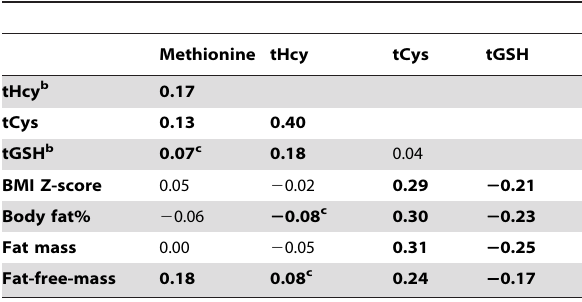
Table 2. Correlations among the sulfur amino acids and body composition.